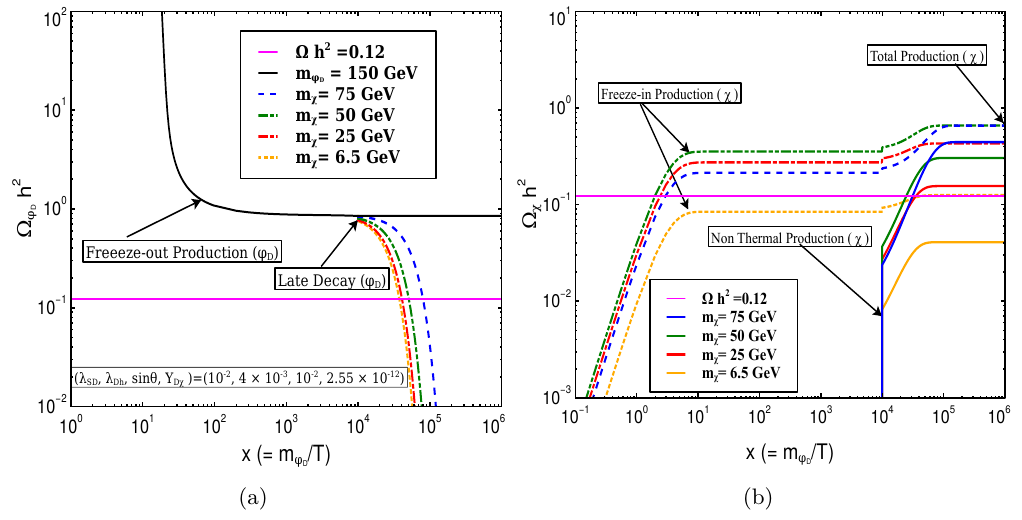
Figure 9 . Left panel: figure 9(a) shows the variation of Ω φ shows the variation of Ω 2 w.r.t. x . This corresponds to the super-wimp dominated scenario. χ h